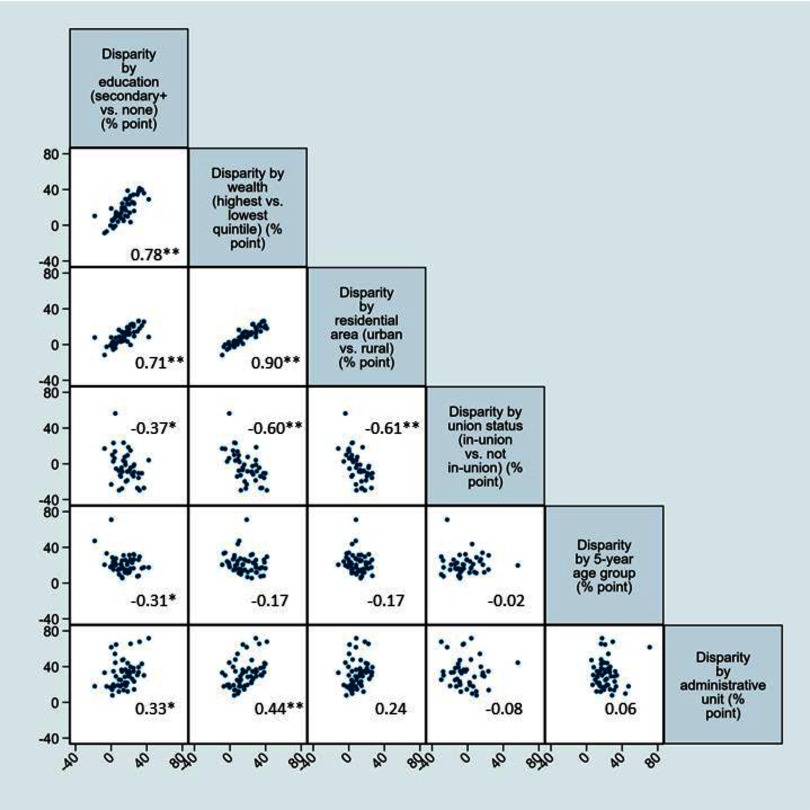
Correlation Matrix Among Various Disparities in Family Planning Demand Met With Modern Methods, With Correlation Coefficient* P value <.05; ** P value <.01.For education, household wealth, and residential area, disparity is between the most- and least-advantaged subgroups. For age and administrative unit, disparity represents the largest possible absolute gap among all subgroups.Data are from the latest DHS from 55 countries.All disparity measures are among women in union, except disparity by union status, which is among all women.